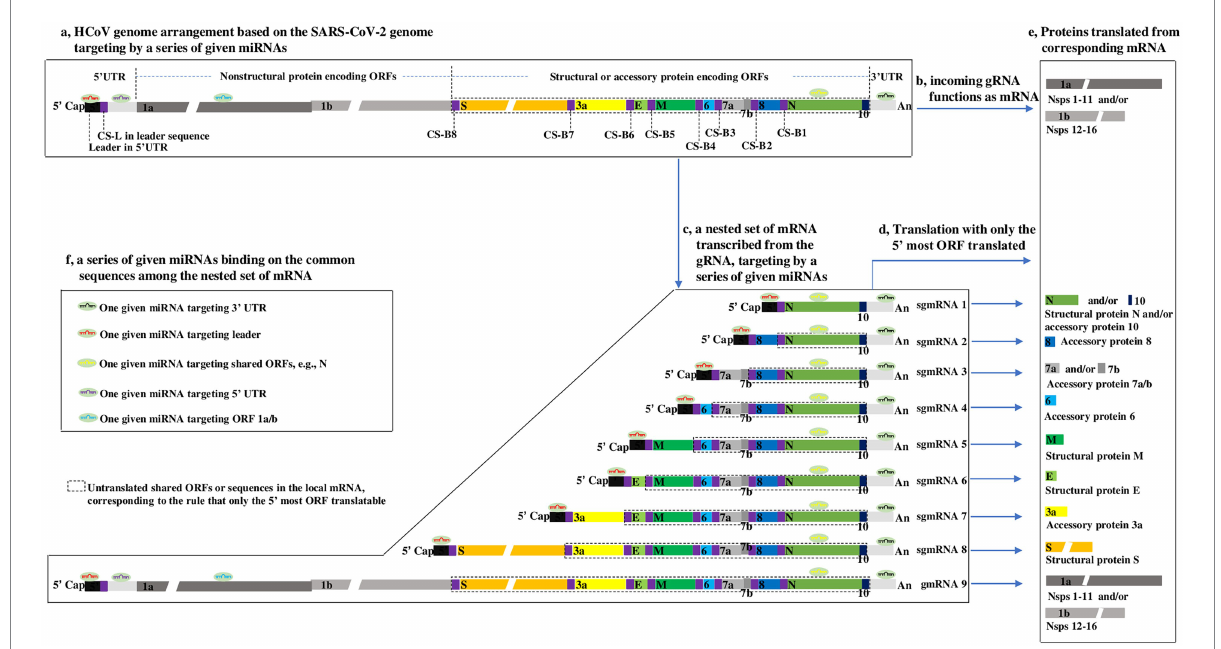
FIGURE 1 Outline showing HCoV genome arrangement, nested set of mRNA (Thiel et al., 2003; Zuniga et al., 2004), translation strategy (Sola et al., 2015), and proposed interaction modes of miRNAs-HCoV mRNAs, based on the SARS-CoV-2 genome (Wu et al., 2020). (a) HCoV genome arrangement. The SARS-CoV-2 genome consists mainly of a 5 ′ cap, a leader, the 5’ UTR, 12 ORFs, 9 CSs within TRS-L or TRS-B, 3’ UTR, and poly (a), arranged according to the aforementioned order. ORFs 7b and 1b are highlighted to indicate that they overlap with ORF 7a and ORF 1a, respectively. The gaps in the ORF 1a, ORF 1b and S indicate that their lengths are presented on different scales due to space limitations. To clearly illuminate the transcription of genome described in Supplementary Figure S3, the lengths of CS-Bs and CS-L are highlighted but do not correspond with their actual lengths, which are proposed to be ~6 nucleotides long. (b) Genomic RNA (gRNA) functions as mRNA. Upon HCoVs entering host cells, the first products synthesized are the nsps from ORF 1a/b in the viral gRNA (Lai and Cavanagh, 1997) when the gRNA can be directly targeted by miRNAs. (c–e) The nested set of HCoV mRNA and their Translation strategy. In most cases, only the 5 ′ most ORF is translated into a protein. The untranslated sequences or ORFs are included in the dotted line. The boxes within the same color refer to the same or complementary sequences or their translated proteins. (f) The proposed interaction modes of miRNAs-HCoV mRNAs. Because of the common sequences shared by the nested set of mRNAs, for a given HCoV, one given microRNA has the potential to target one, many or all viral